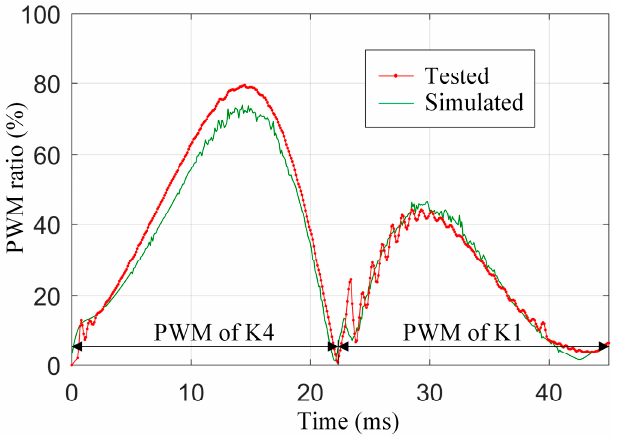
Figure 10. Comparison of the tested and simulated PWM ratio.